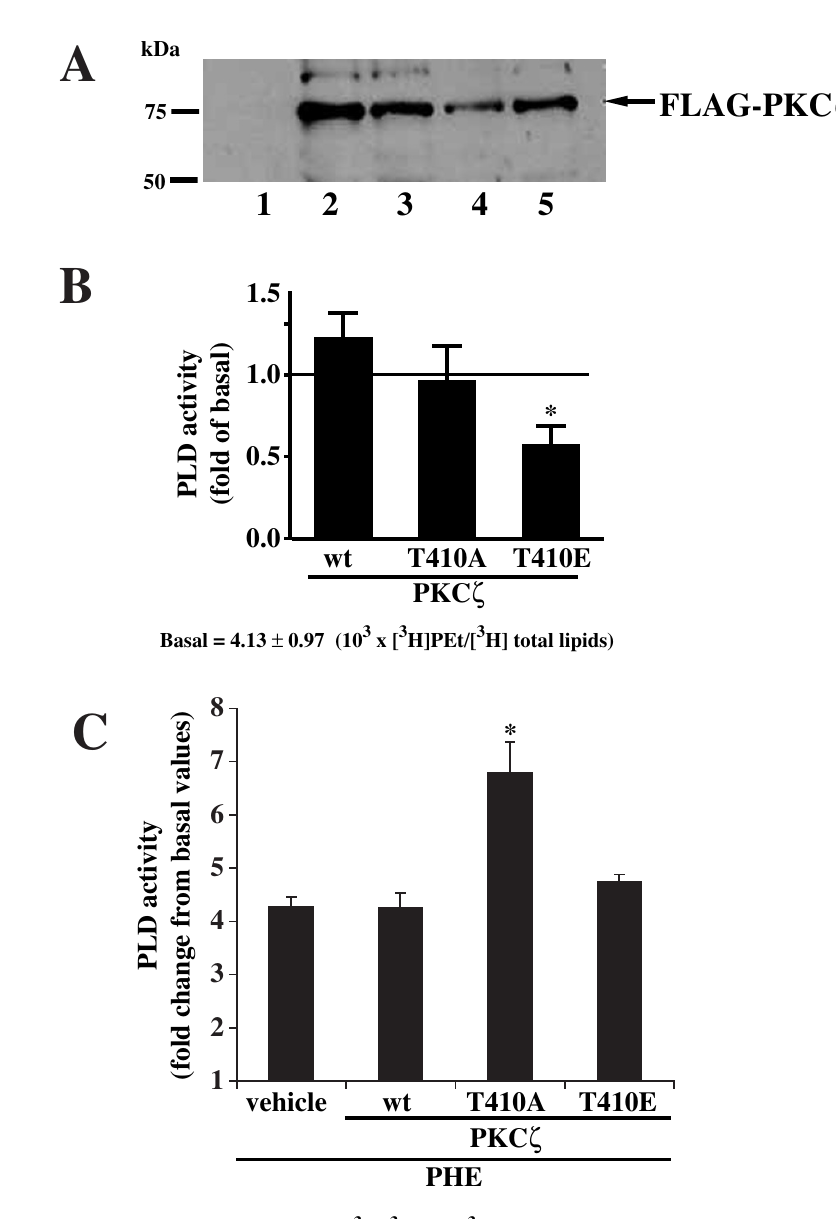
Figure 6 Effect of catalytically active and inactive PKC ζ mutants on PLD activity. A, Representative Western blot showing the transfection of pCMV-FLAG-PKC ζ constructs using an anti-FLAG antibody. Samples were immunoprecipitated with anti- FLAG antibody and probed with the same antibody; 1: untransfected, 2: pCMV-FLAG wt PKC ζ , 3: pCMV-FLAG T410A PKC ζ , 4 and 5: pCMV-FLAG T410E PKC ζ . B, Cells were transiently transfected with wt PKC ζ , kinase-deficient T410A PKC ζ and constitutively active T410E PKC ζ for 48 h and PLD activity was determined as described in Methods. Data are expressed as the change in PLD activity as a fraction of basal activity (non transfected cells). Values are the mean ± S.E. of three independent experiments performed in duplicate on different batches of cells. * Value significantly different from basal p < .01. C, PHE- induced increase in PLD activity was adjusted for basal variations in the absence of PHE (shown in panel B) for each treatment (vehicle, wt, T410A, T410E). PLD activity was calculated as [PKC ζ construct + PHE / [PKC ζ construct alone]. This data pres- entation allows the elimination of non specific variations of basal PLD activity due to the overexpression of the PKC ζ con- structs. Values are the mean ± S.E. of three independent experiments performed in duplicate on different batches of cells. * Value significantly different from vehicle, p <